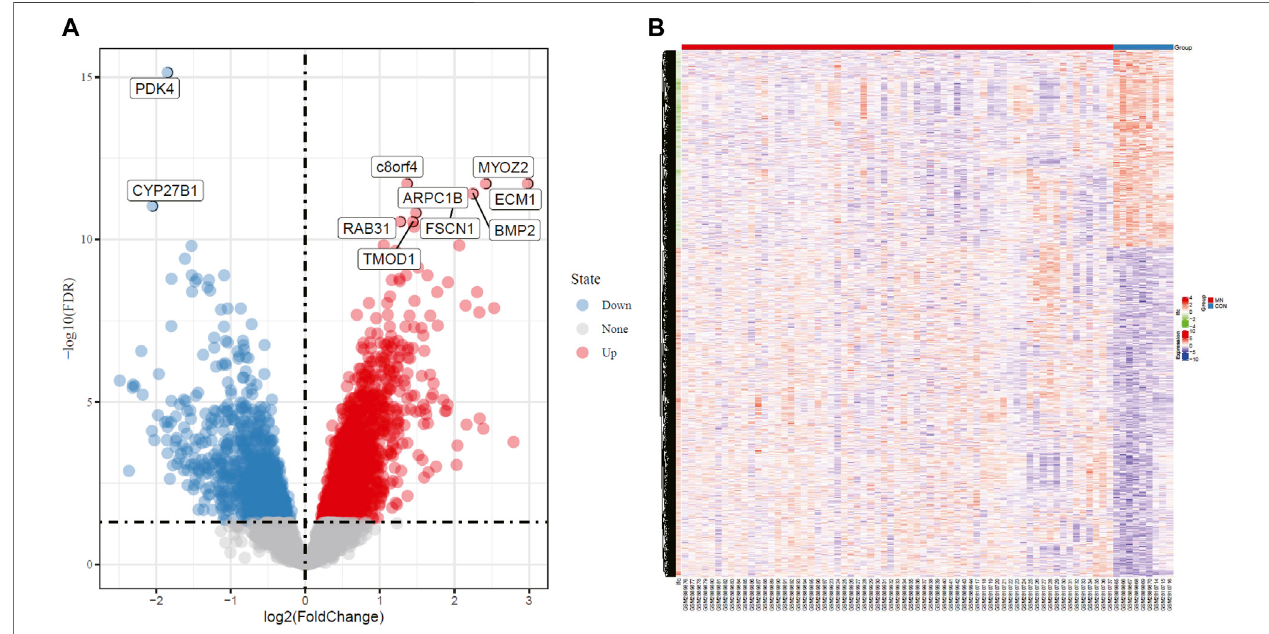
FIGURE1 | Volcano plot and Heatmap analysis identi fi es DEGs. (A) Red dots representupregulated genes and blue dots represent downregulated genes inrenal glomerular tissue fromMNpatientscompared with normalcontrols. (B) Red areas represent highly expressed genesand blue areas represent lowlyexpressed genesin renal glomerular tissue from MN patients compared with normal controls. DEG, differentially expressed gene; MN, membranous nephropathy.